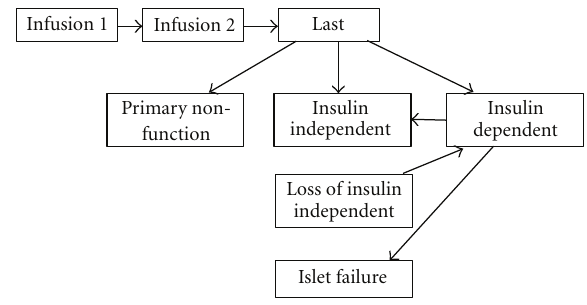
Figure 3: Possible states after last